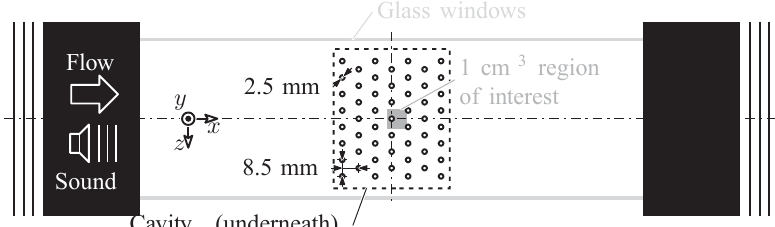
Figure 4. Top view of the setup of the aeroacoustic measurement in a generic bias flow liner with optical access through glass windows; the point of origin is at the center of the central orifice.